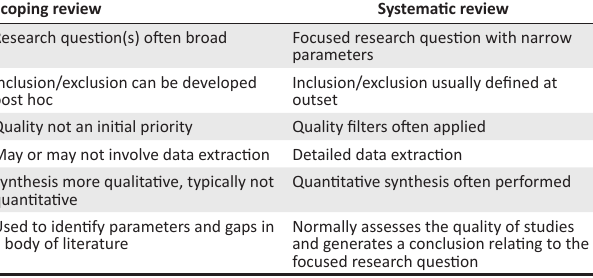
TABLE 1: A comparison of the characteristics of scoping and systematic reviews. Scoping